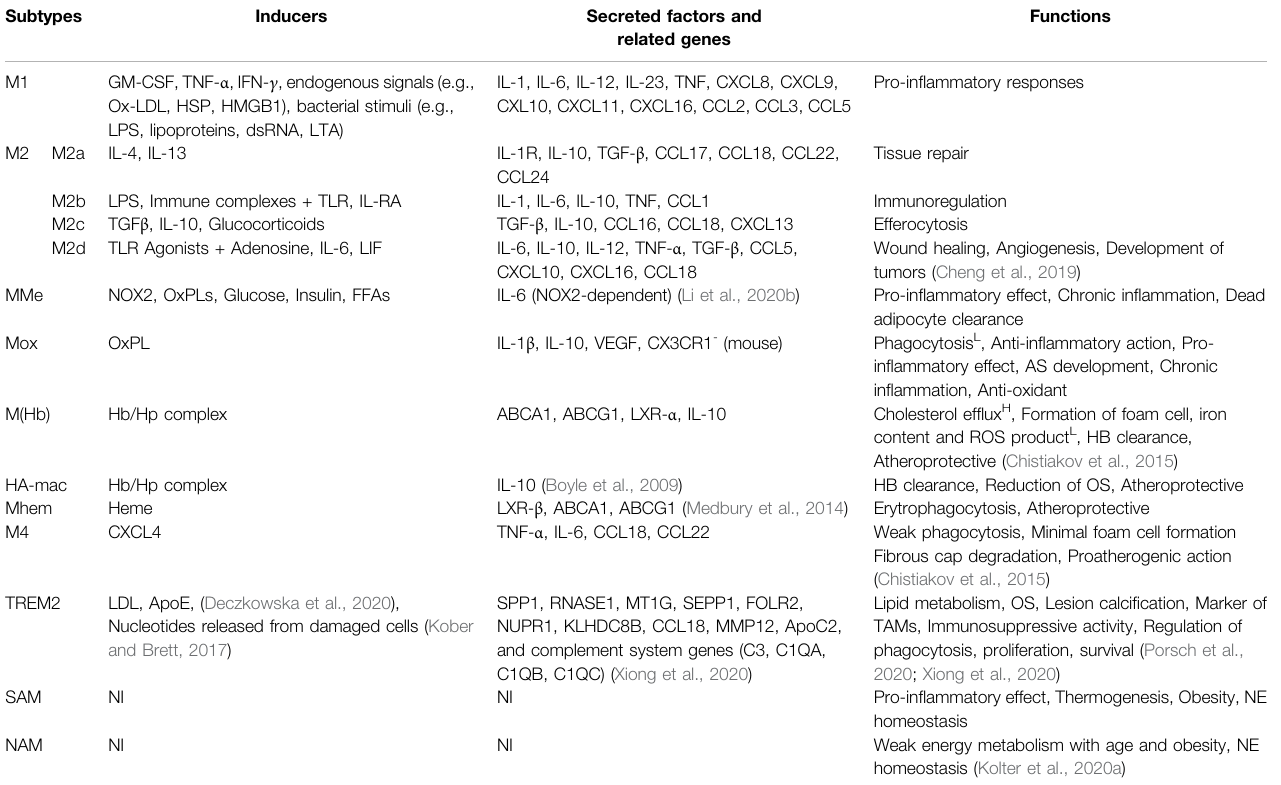
TABLE 2 | Activating stimuli, properties, and functions of polarized macrophage